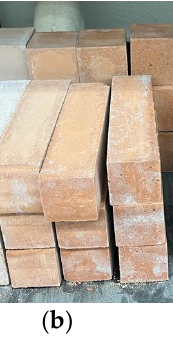
Figure 1. Representative samples used for testing. ( a ) DCP; ( b ) DCP + RM.